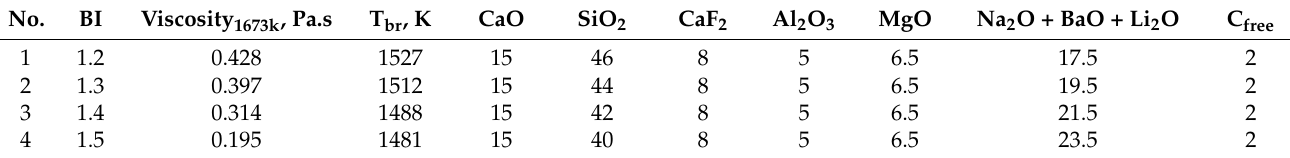
Table 2. Composition and basic physical properties of initial slags,